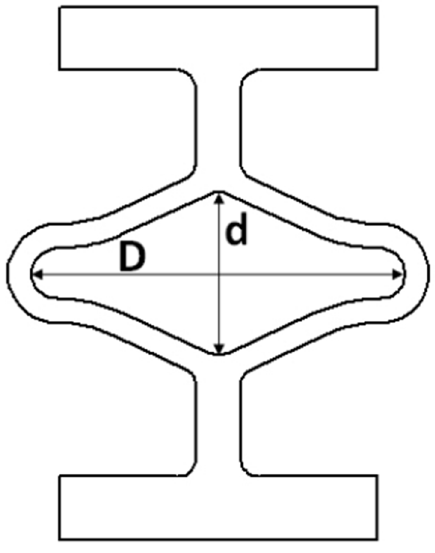
Figure 1. Schematic of the laser-cut diamond-shaped device (D = 5.9 mm and d = 1.7 mm).